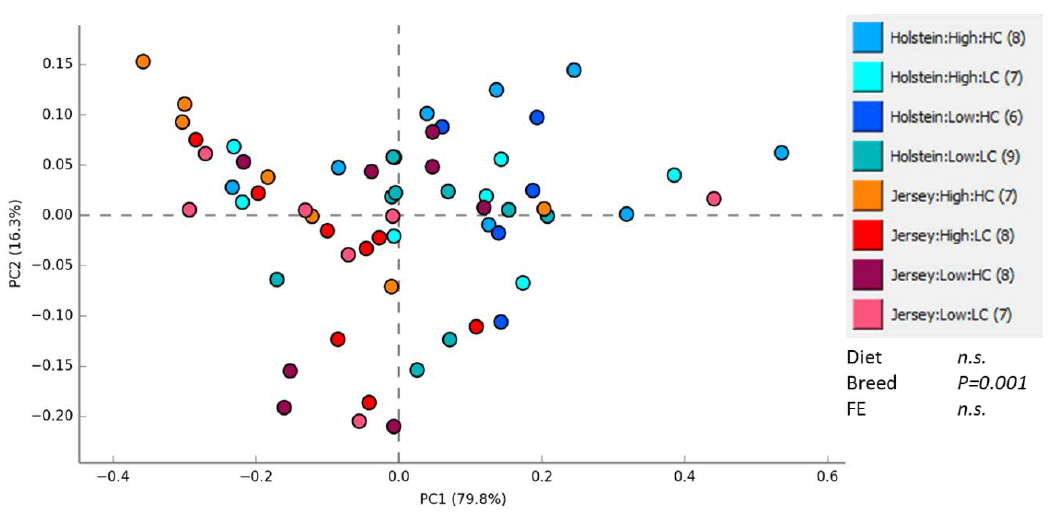
Figure 1. Principal component analysis (PCA) of the methanogen community in the rumen grouped by breed (Holstein or Jersey), residual feed intake (RFI) group (High or Low), and diet (high concentrate: HC; and low concentrate: LC) combinations. Methanogen communities were characterized by T-RFLP analysis on the mcrA gene. The effects of experimental factors were tested using a non-parametric multiple ANOVA on the Bray–Curtis distances.